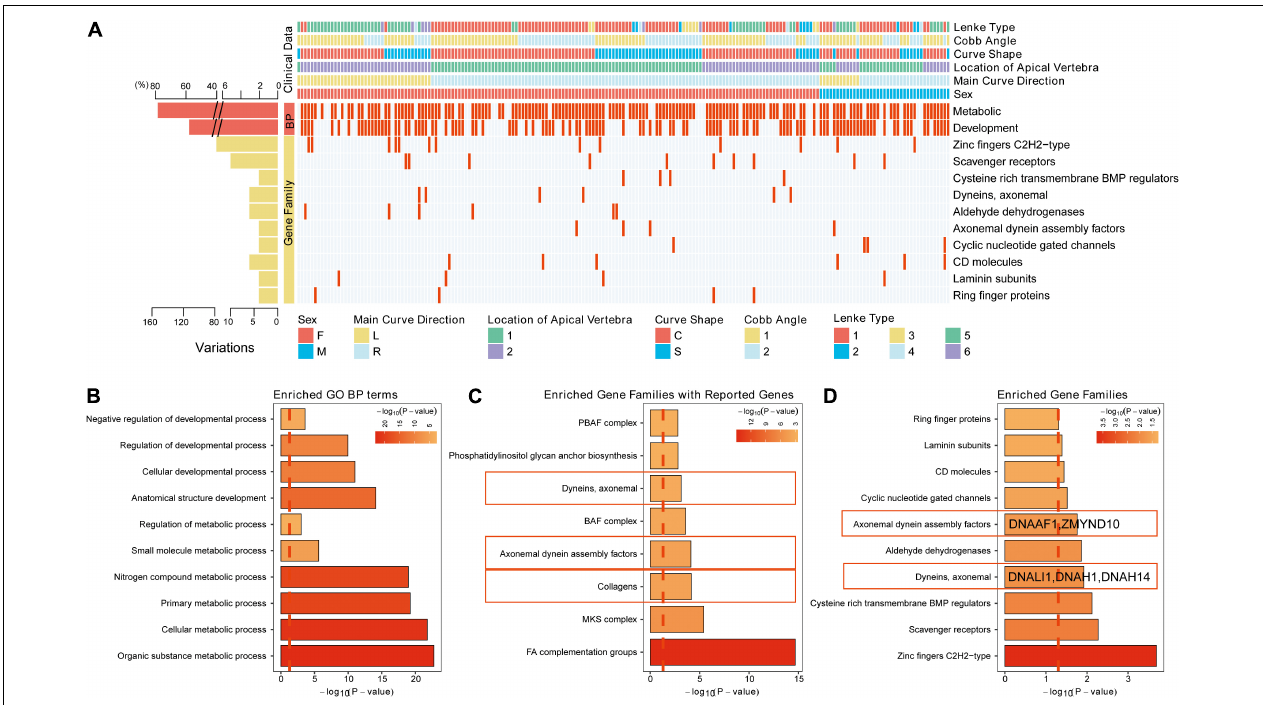
FIGURE 2 | The variants identified from Southern Chinese AIS patients. (A) Genetic variations detected in gene families and related biological processes (BPs). Each row represents an individual gene family or BP category. The altered individuals and frequency of each gene are noted on the left. Each column representing an affected sample with clinical features is indicated by the color key. The occurrence of a variant with gene in corresponding terms across an individual sample is shown by a red (missense variant) or blue (no variant) color scheme. Sex, F = female, M = male. Main curve direction represents the sideness of the major curve, L = left, R = right. Location of the apical vertebra represents the axial location of the apical vertebrae, 1 = T1–T9 vertebrae, 2 = under the T10 vertebra. Curve shape, C = “C”-shaped curve, S = “S”-shaped curves. Cobb angle, 1 = below the mean Cobb angle, 2 = above the mean Cobb angle. Lenke type, 1 = type 1, 2 = type 2, 3 = type 3, 4 = type 4, 5 = type 5, and 6 = type 6. (B) The top 10 enriched Gene Ontology (GO) BP terms in our study. (C) The top enriched gene families with the genes in previous studies or database. (D) The top enriched gene families with the genes reported in our